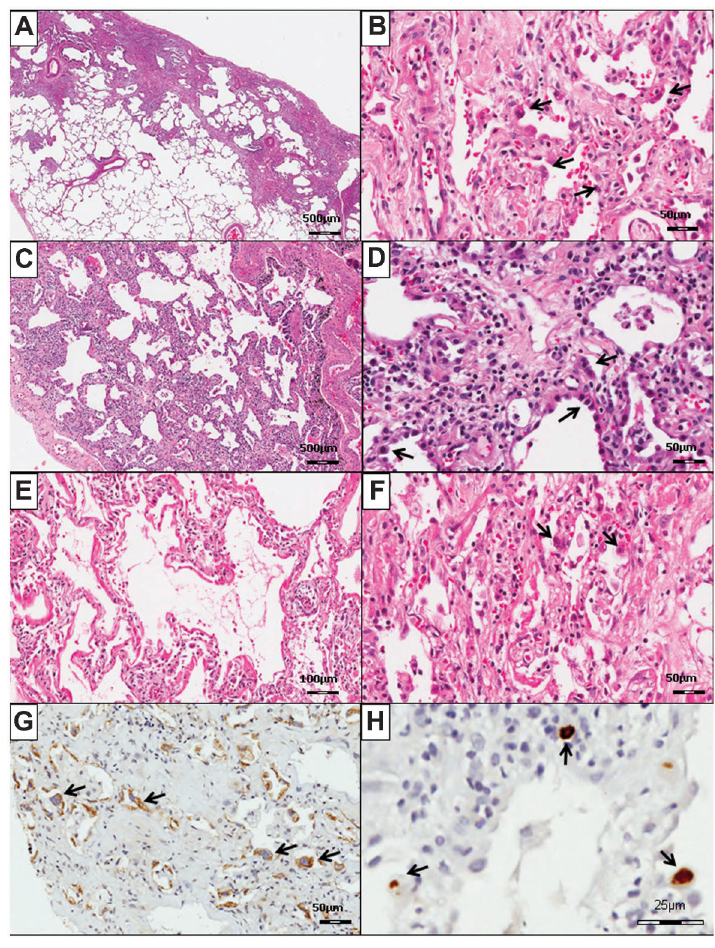
Figure 1. Panoramic view of the lung in usual interstitial pneumonia ( A ), nonspecific interstitial pneumonia ( C ) and diffuse alveolar damage- related ( E ) histological patterns and immunohis- tochemistry for measles virus (MV) ( G ) and cytomegalovirus (CMV) ( H ). At high magnifica- tion, note that prominent cuboidal hyperplasia of type II pneumocytes line the thickened interstitium in usual interstitial pneumonia ( B ) and nonspecific interstitial pneumonia ( D ). In panel F , diffuse alveolar damage was characterized by hyaline membranes and interstitial acute inflammation in a uniform temporal appearance present in diffuse distribution. In panels B , D and F , the characteristics of the nuclear cytopathic effect (arrows) are shown. In panels G and H , MV and CMV intranuclear inclusion is visible after